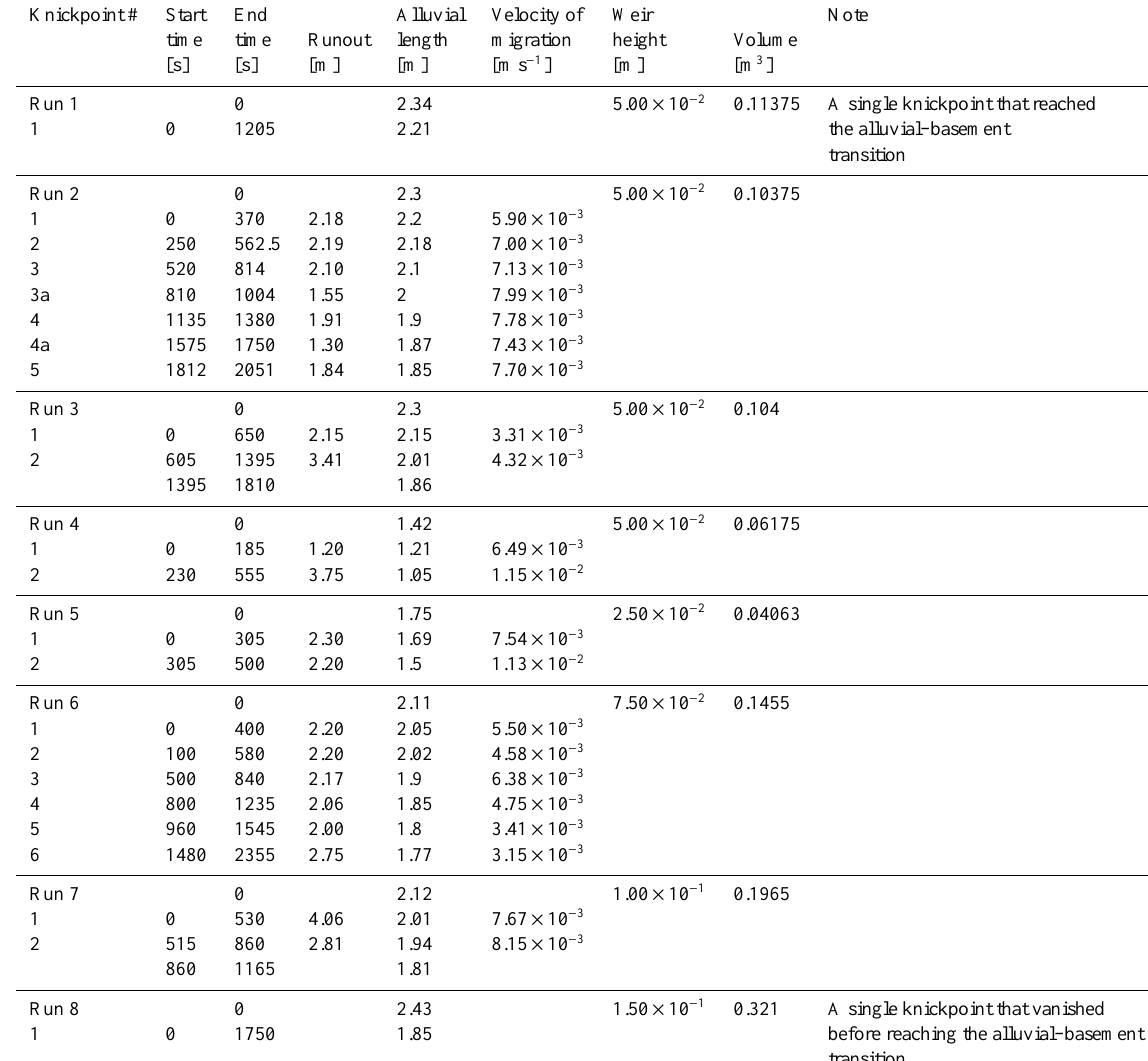
Table 2. Characteristics of the